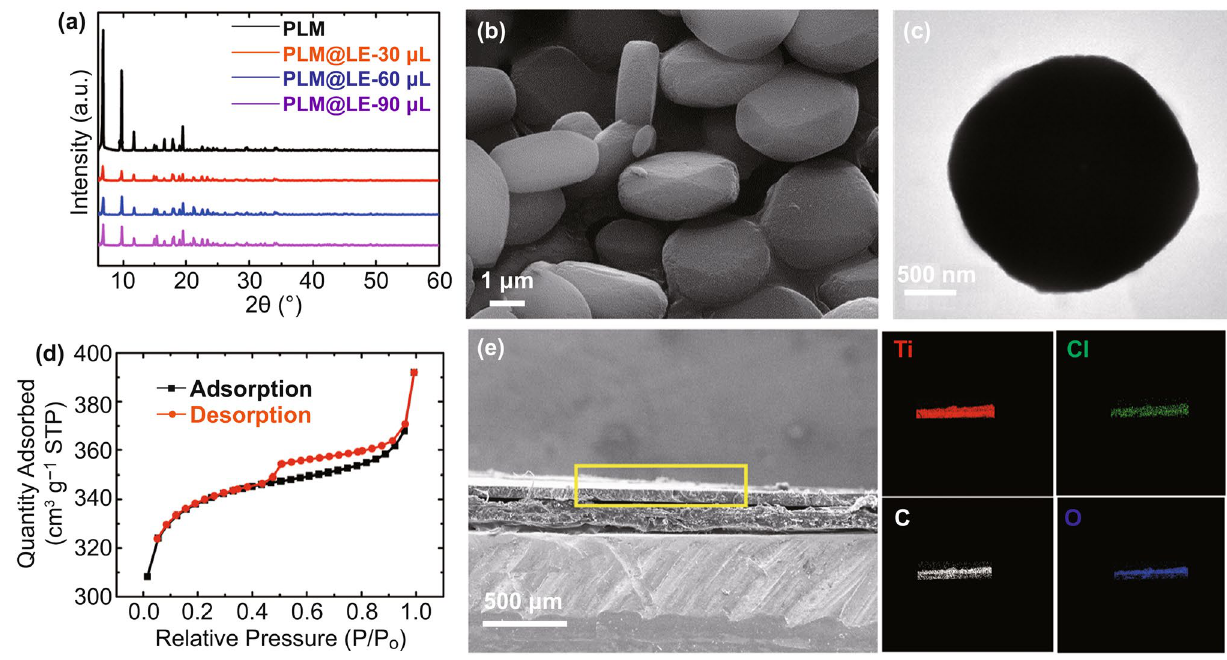
Fig. 2 a XRD patterns of PLM and PLM with different LE contents. b SEM and c TEM image of PLM. d N 2 adsorption/desorption isothermal linear plots of PLM. e Cross-sectional SEM and EDS images of